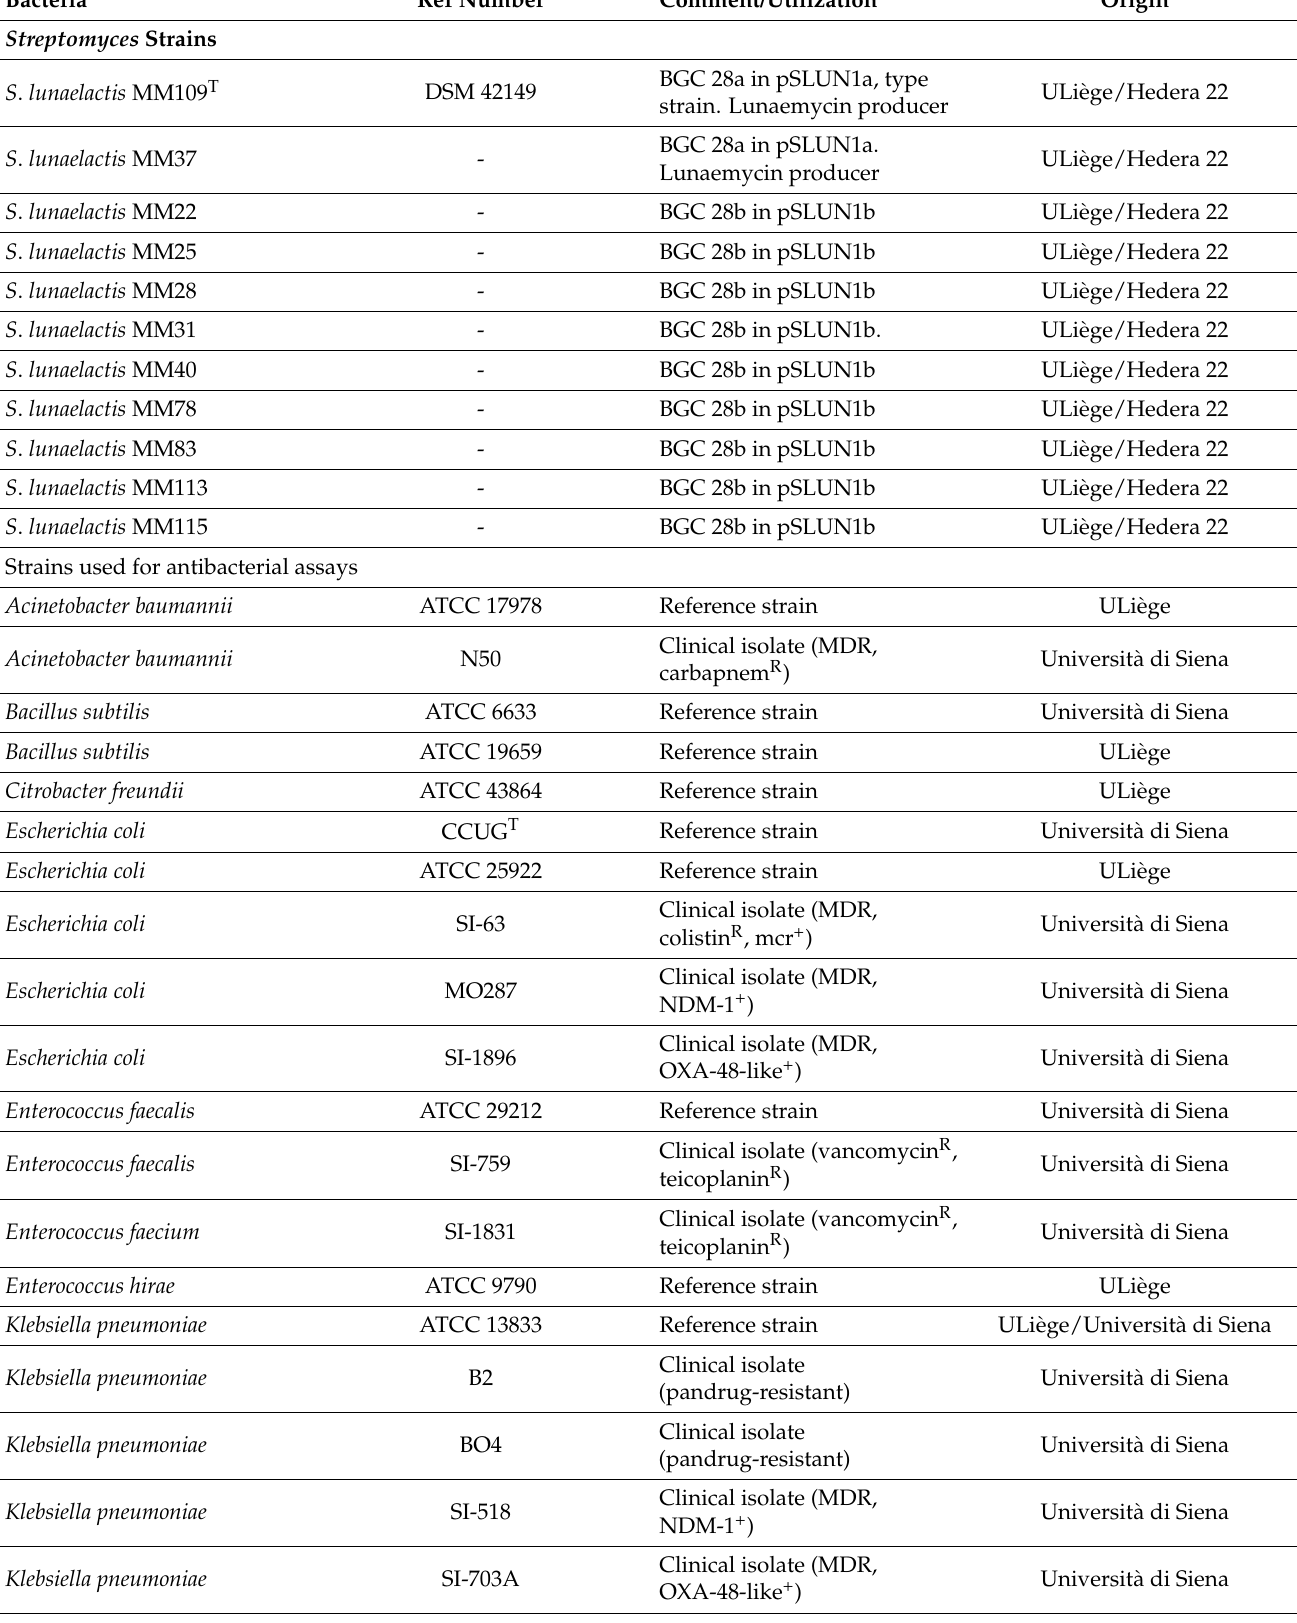
Table 5. List of bacterial strains used in this